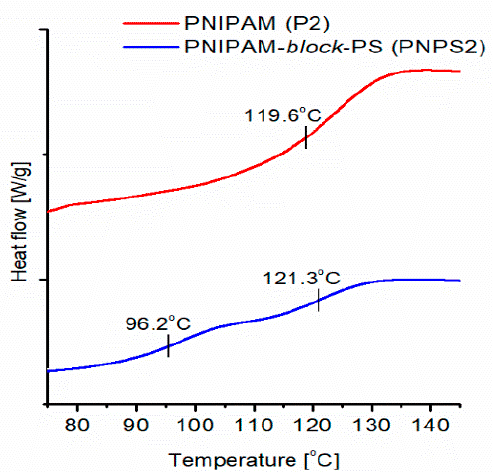
Figure 10. The DSC thermograms for the synthesized homopolymer, copolymer and T g s determined from the thermograms (cooling scan, cooling rate of 20 K/min).